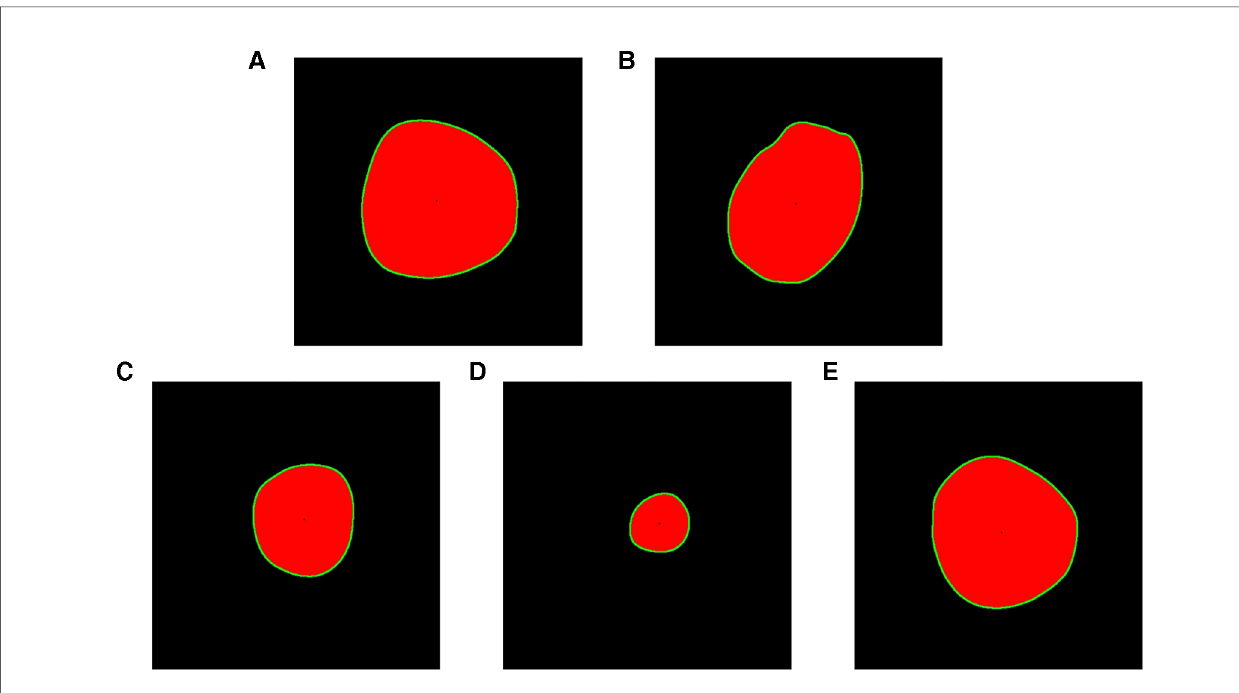
FIGURE 5 Drawing contours and geometric centers. ( A ) Ascending aortic cross section. ( B ) Proximal transverse arch cross section. ( C ) Distal transverse arch cross section. ( D ) Aortic isthmus cross section. ( E ) Descending aorta cross